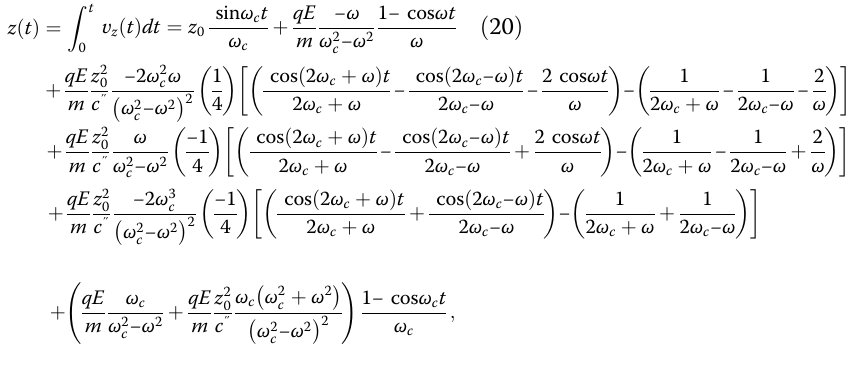
time t = 0. The results are: